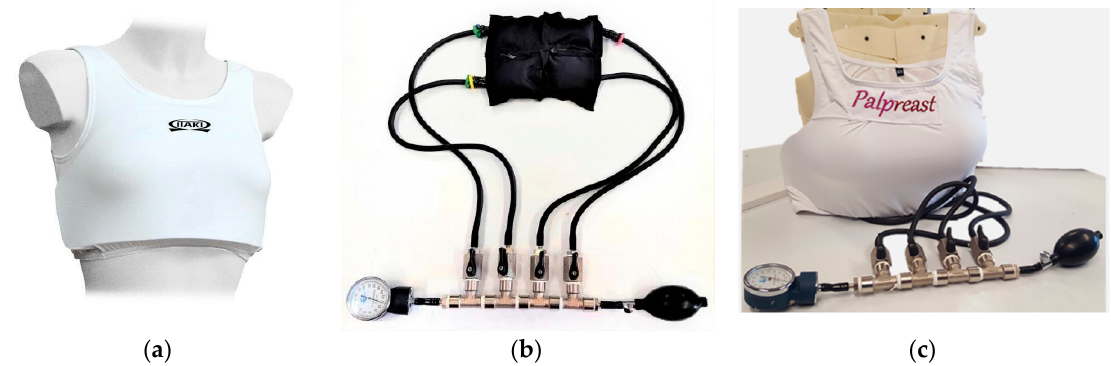
Figure 11. Palpreast prototype—( a ) stretchy top with a rigid protective structure; ( b ) inflator system; and ( c ) assembled